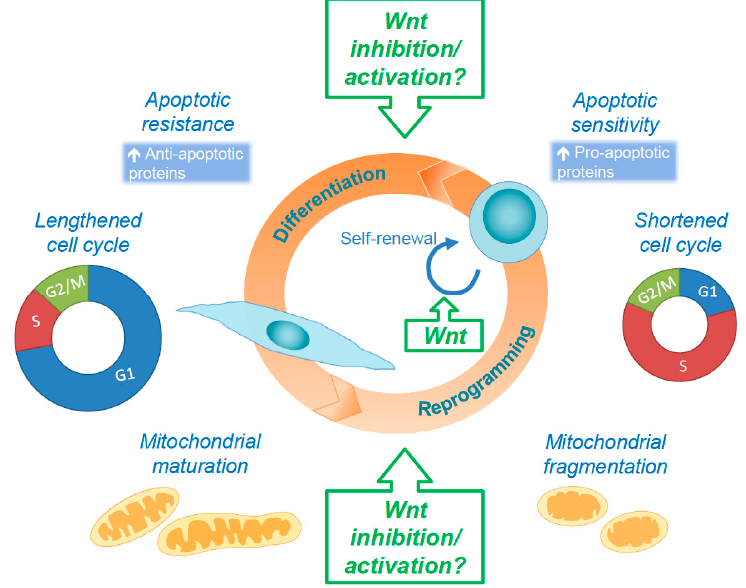
Figure 4. Stem cell properties of self-renewal and pluripotency and their modulation by Wnt. Pluripotent stem cells have (1) high mitochondrial fragmentation, (2) increased sensitivity to apoptosis, and (3) shortened cell cycle due to abbreviated G1 phase. These properties change dynamically over the course of differentiation. Wnt signaling pathways, both canonical and non-canonical, impacts these processes, and inhibition or activation of Wnt can promote pluripotency or